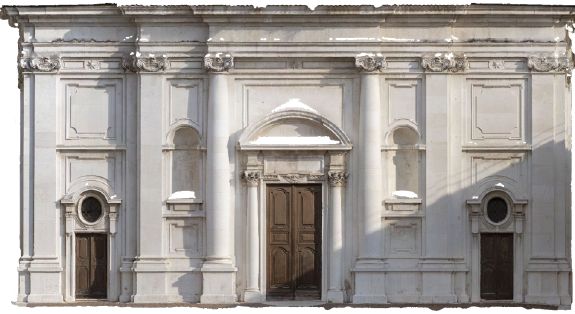
Figure 2. Ortho-rectified image of the